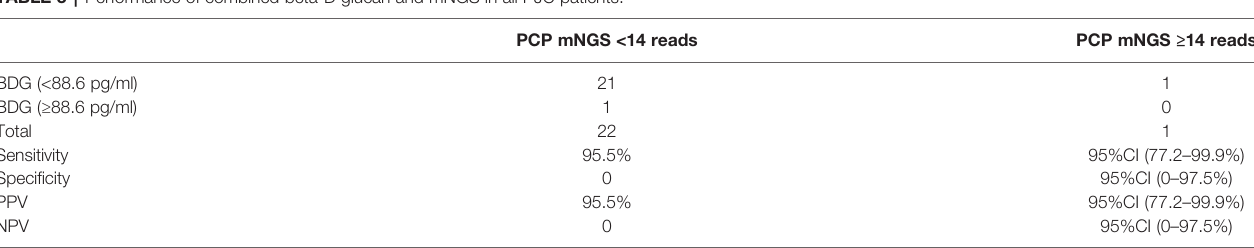
TABLE 3 | Performance of combined beta-D glucan and mNGS in all PJC patients.